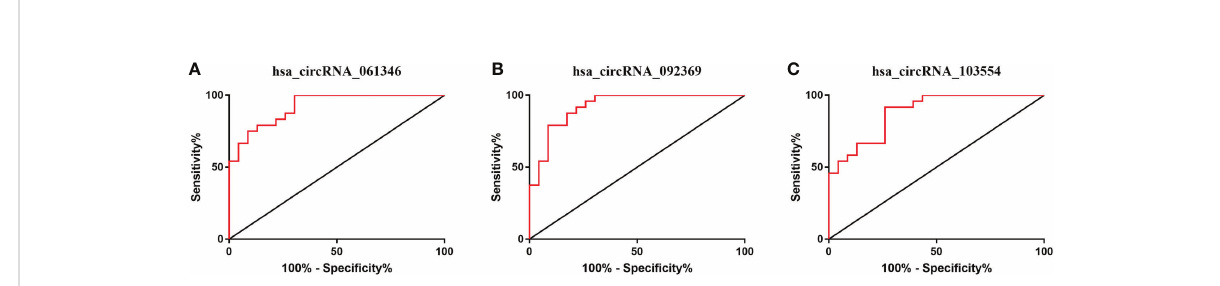
FIGURE 8 Receiver operating characteristic (ROC) curve analyses of hsa_circRNA_061346 (A) , hsa_circRNA_092369 (B) , and hsa_circRNA_103554 (C) in patients with retinopathy of